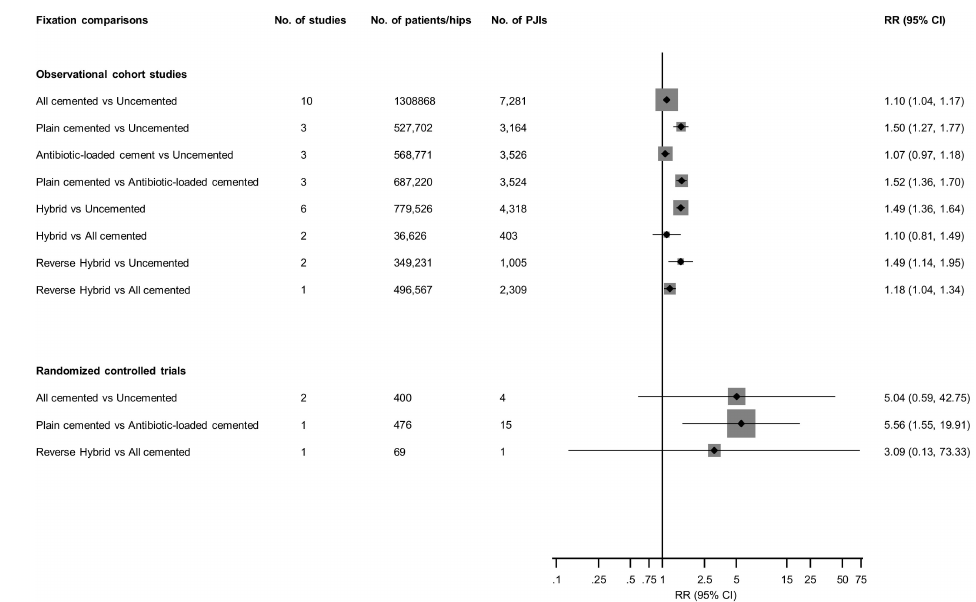
Figure 2. Fixation types and risk of prosthetic joint infection in observational and interventional studies. CI, confidence interval (bars); PJI, prosthetic joint infection; and RR, relative